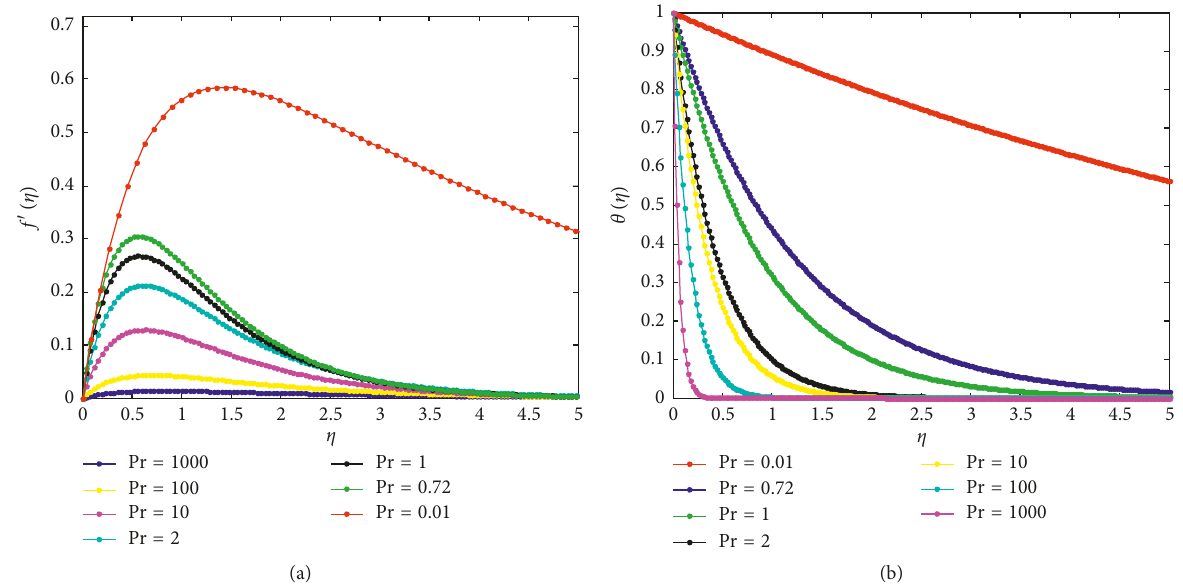
Figure 16: (a) Effects of Prandtl number on the velocity profile for TiO profile for TiO 2 nanoparticle.